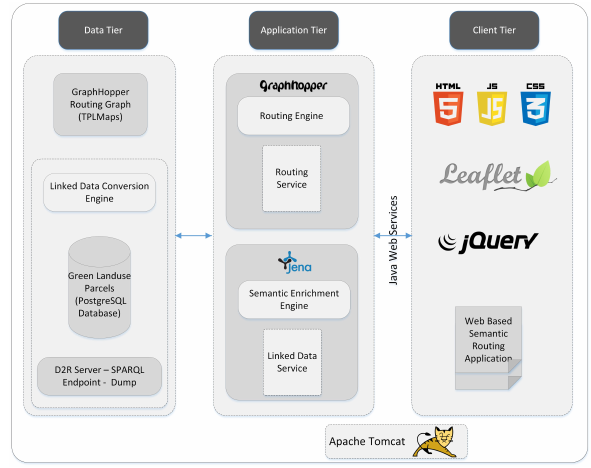
Figure 1. Architecture